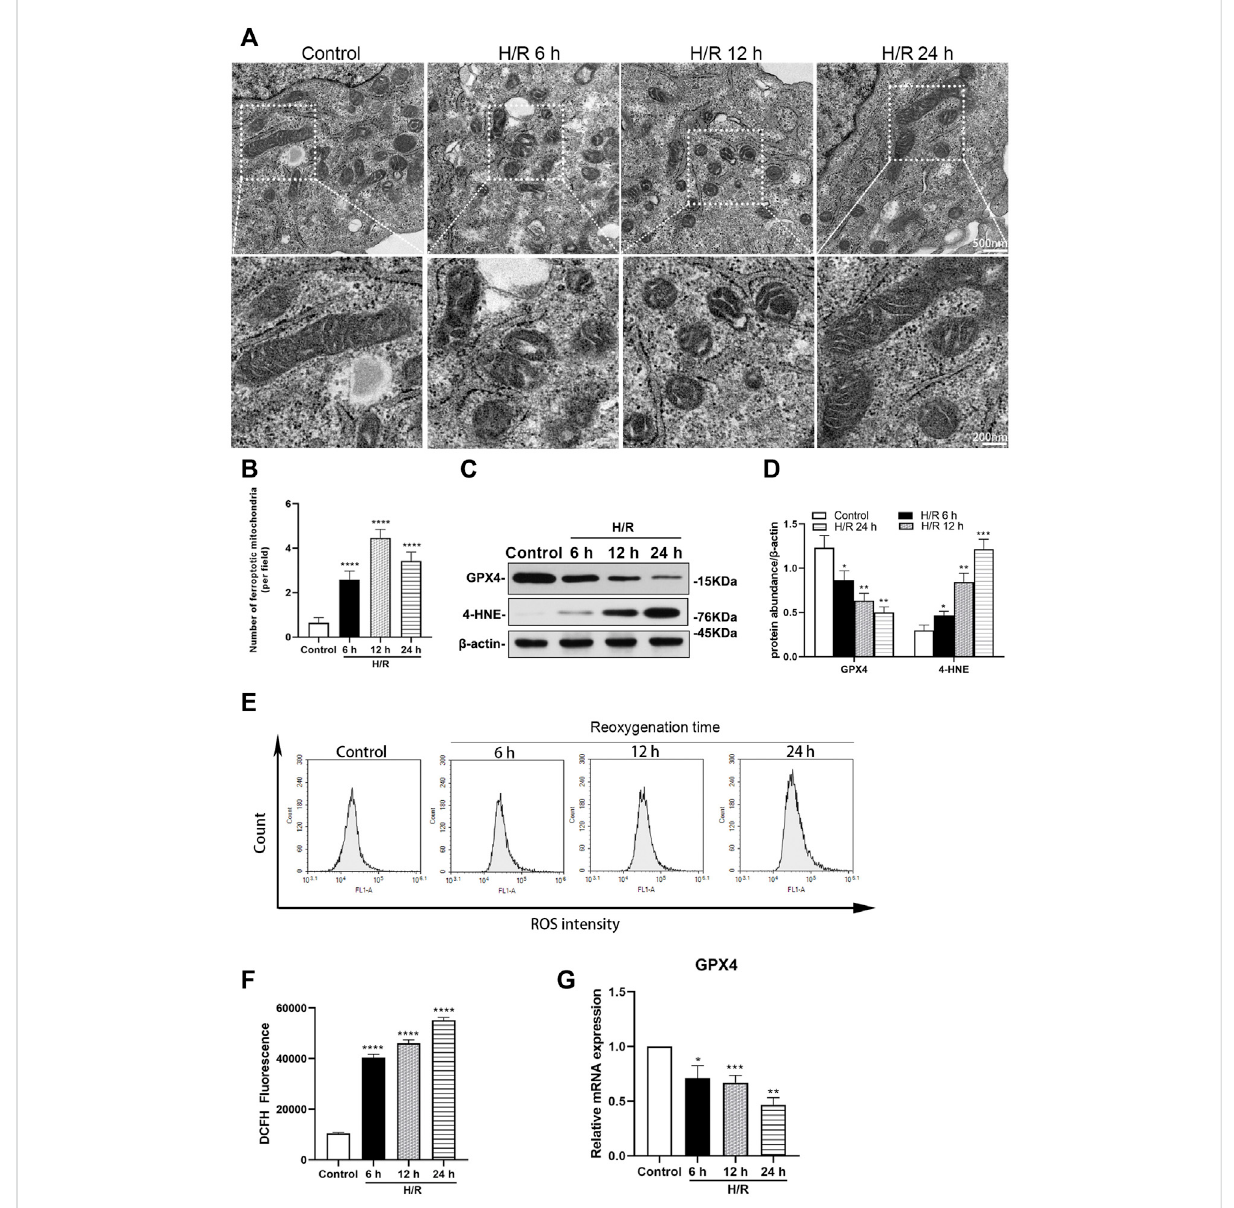
FIGURE 4 Detection of ferroptosis in H/R HK-2 cells at 6, 12, and 24 h after H/R (A) Transmission electron microscopy was used to observe the mitochondrion of HK-2 cells (B) The number of ferroptotic mitochondria per fi eld in different groups were compared, the number was highest at 12 h ( p < 0.0001) (C) Representative western blotting of GXP4 and 4-HNE, β -actin used as an internal control (D) Protein synthesis of GXP4 and 4- HNE in western blotting (E) Flow cytometry showed that the level of reactive oxygen species (ROS) in the control group and H/R HK-2 cells